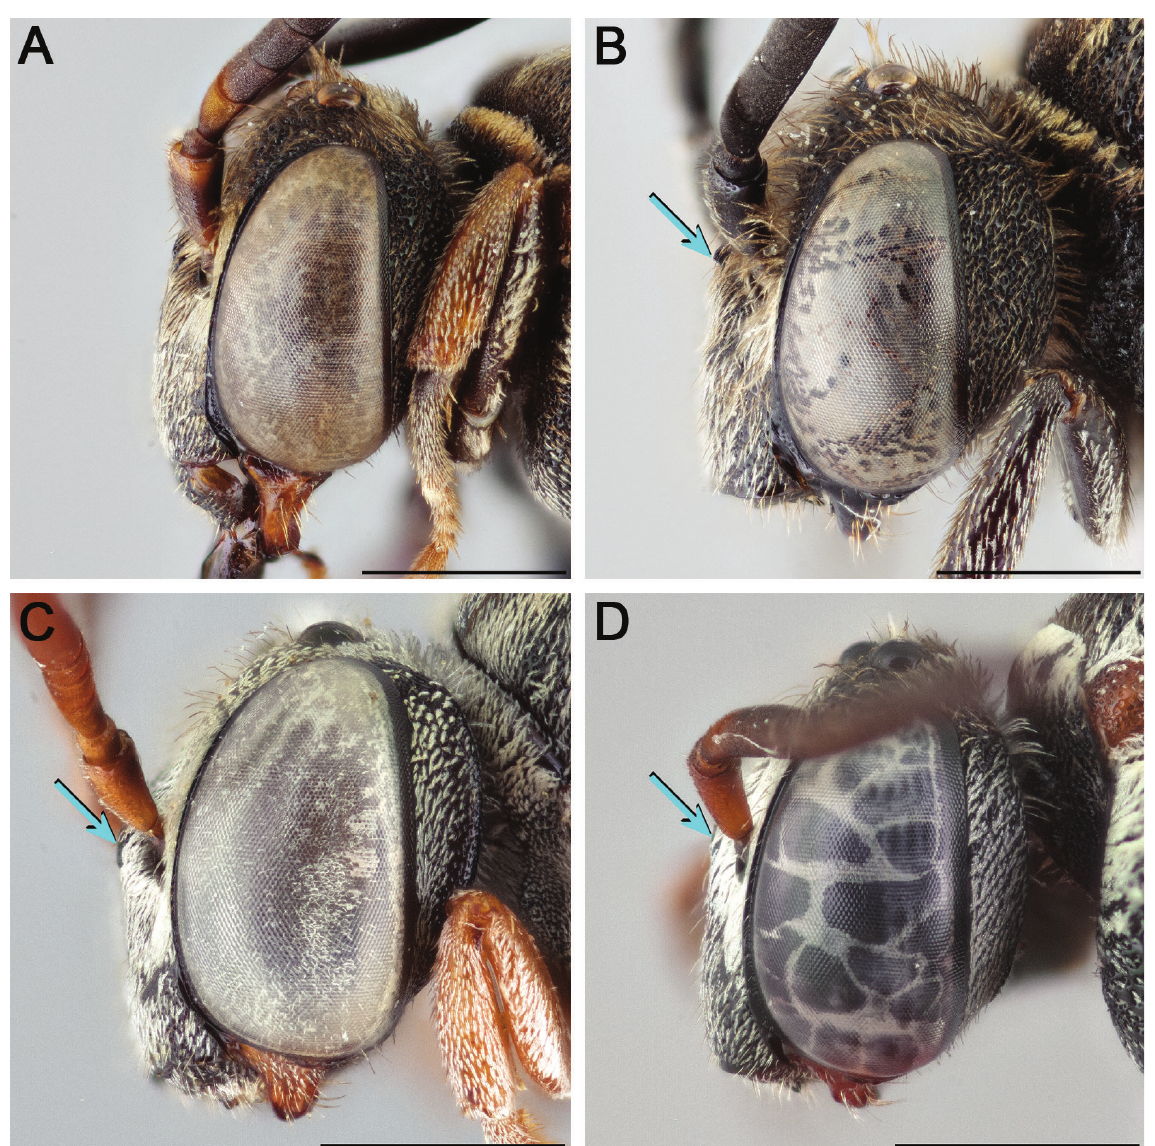
Fig. 27. Head of female, lateral view. A . E. luteipennis Friese, 1916, in which the frontal keel lacks a tooth-like process. B . E. odyneroides sp. nov., holotype (KUNHM SM0253729), in which the frontal keel has a small tooth-like process (blue arrow). C . E. australis Mitchell, 1962, in which the frontal keel (blue arrow) is strongly raised. D . E. brumleyi Onuferko, 2018, paratype, in which the frontal keel (blue arrow) is weakly protuberant by comparison. Scale bars = 1